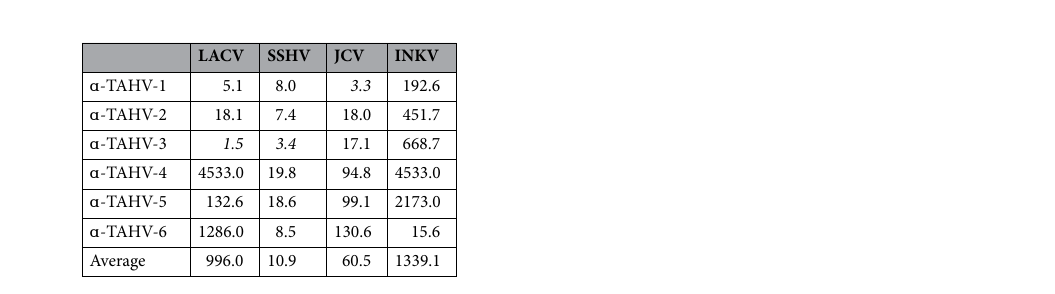
Table 5. ND50 fold difference of ɑ -TAHV plasma between heterologous viruses vs. homologous TAHV. Italics = < fourfold difference.